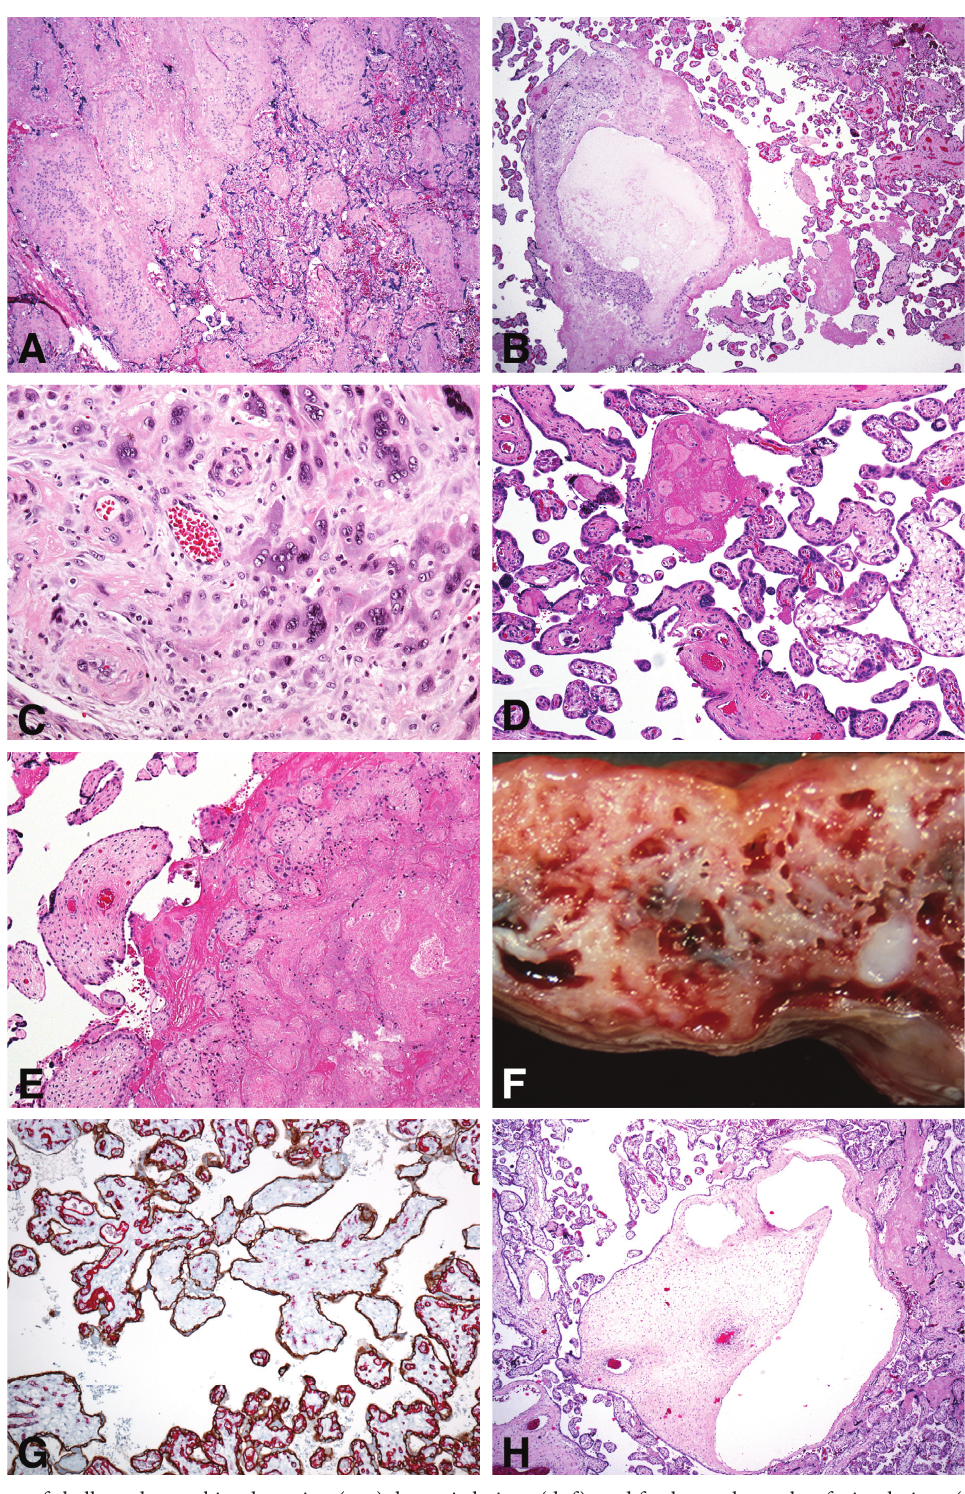
Figure 2: Lesions of shallow placental implantation (a–c), hypoxic lesions (d–f), and fetal vascular malperfusion lesions (g, h) statistically significant more common in group 1 (original objective magnifications are given in parentheses). (a) Confluent cell islands (excessive extravillous trophoblasts) (haematoxylin eosin, 4x). (b) Chorionic microcysts (haematoxylin eosin, 4x). (c) A cluster of multinucleate trophoblasts and hypertrophic decidual arteriopathy in maternal floor (haematoxylin eosin, 40x). (d) Uterine chronic hypoxic pattern at 34weeks gestation (haematoxylin eosin, 10x). (e) Villous infarction (haematoxylin eosin, 10x). (f) Massive perivillous fibrinoid deposition (dissecting microscopy). (g) Incipient segmental villous hypovascularity (E cadherin (brown)/CD34 (red) immunostain, 10x). (h) Fetal stem vascular ectasia, global fetal vascular malperfusion (haematoxylin and eosin,